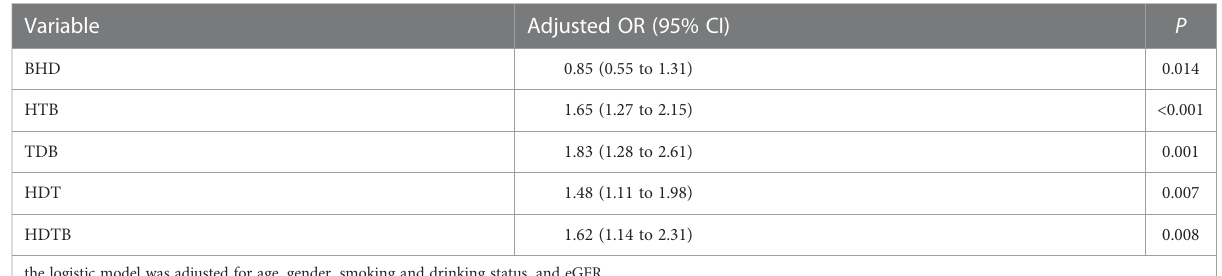
the logistic model was adjusted for age, gender, smoking and drinking status, and eGFR. The MetS phenotype were de fi ned as: